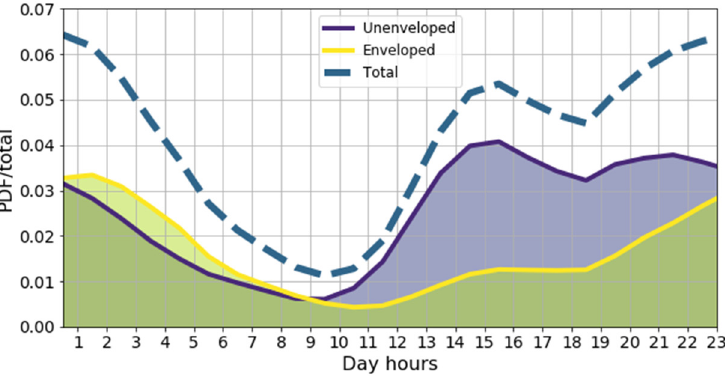
Figure 7. Hourly distributions of the occurrence of total convective (dashed blue), unenveloped (purple), and enveloped (yellow) systems.